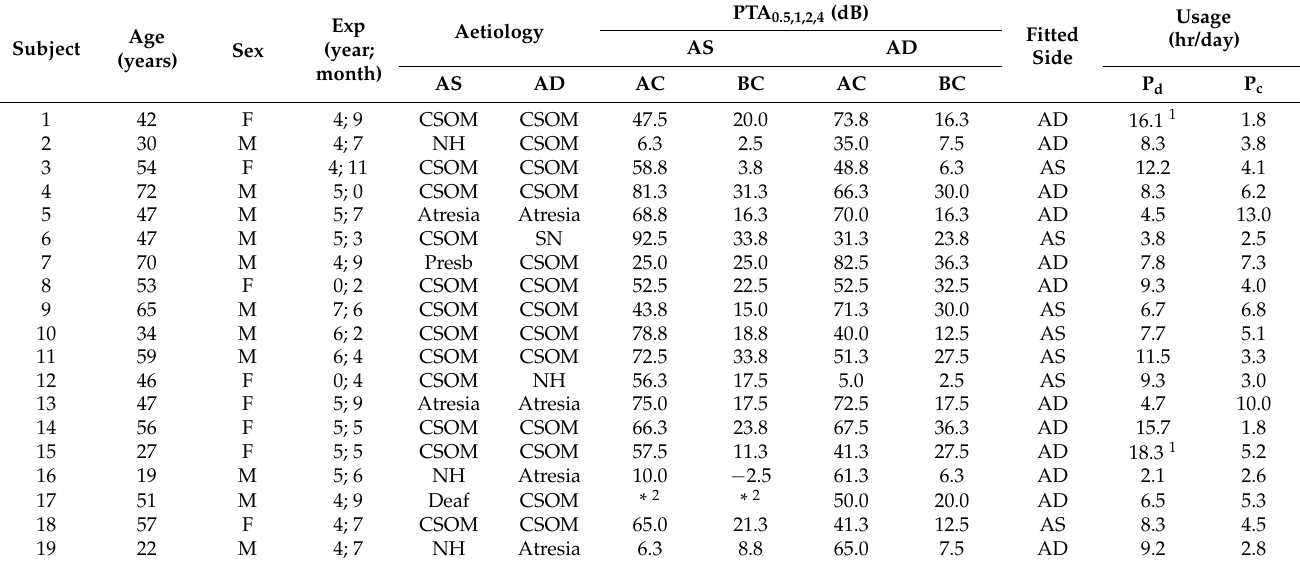
Table 1. Subject characteristics. Columns from left to right: subject, age in years, sex, experience with BCD (years; month), aetiology of hearing impairment for left (AS) and right (AD) side (NH: normal hearing; CSOM: chronic suppurative otitis media; Atresia: congenital atresia of the ear canal; SN: sensorineural loss; Presb: Presbycusis), pure-tone average thresholds for left and right side at 0.5, 1, 2, 4 kHz for air conduction (AC) and bone conduction (BC), fitted side, and usage of the listening programs during the 4-week trial period (default program: Pd, custom program Pc) in hours/day. Most subjects had about 5-years of BCD experience, except for subjects 8 (2 months) and 12 (4 months). Usage time was recorded directly from the BCD. Subjects 1 and 15 did not switch off their BCD but used standby when not in